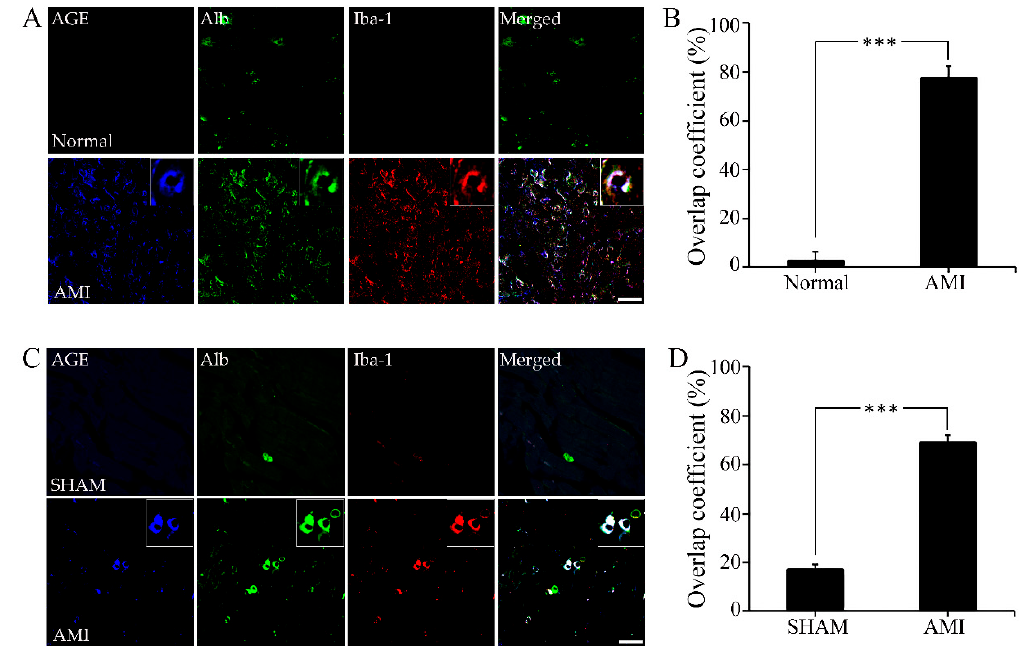
Figure 1. Co-localization of AGE-albumin and activated macrophage cells in the ischemic reperfusion injured heart of human and rat. ( A ) Triple-labeled immunostaining of AGE (blue), albumin (green), and Iba1 (red, activated microglial cell marker) in the left ventricle of human ( A ) and rat ( C ). Merged image shows that AGE (blue), albumin (green), and Iba1 (red, activated microglial cell marker) were co-localized mostly in infarcted area of heart. Fluorescence expression level ( B , D ) and co-localization coefficient analyzed by densitometry analysis software using Zen software (Zeiss). Scale bar = 50 µ m; ***, p < 0.001.